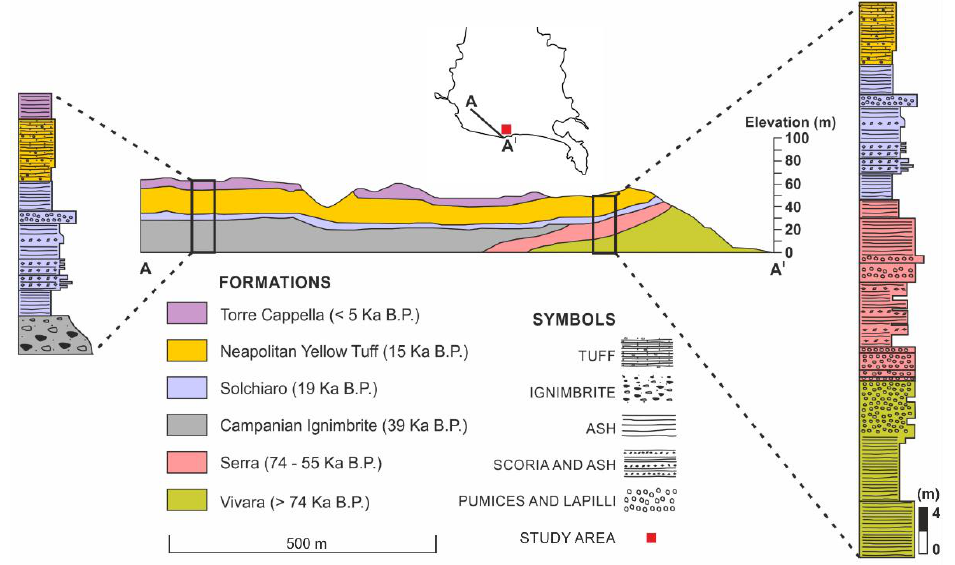
Figure 2. Stratigraphic section representing the geological setting of the study area (modified from Perrotta et al. [41] and Esposito et al. [30]).